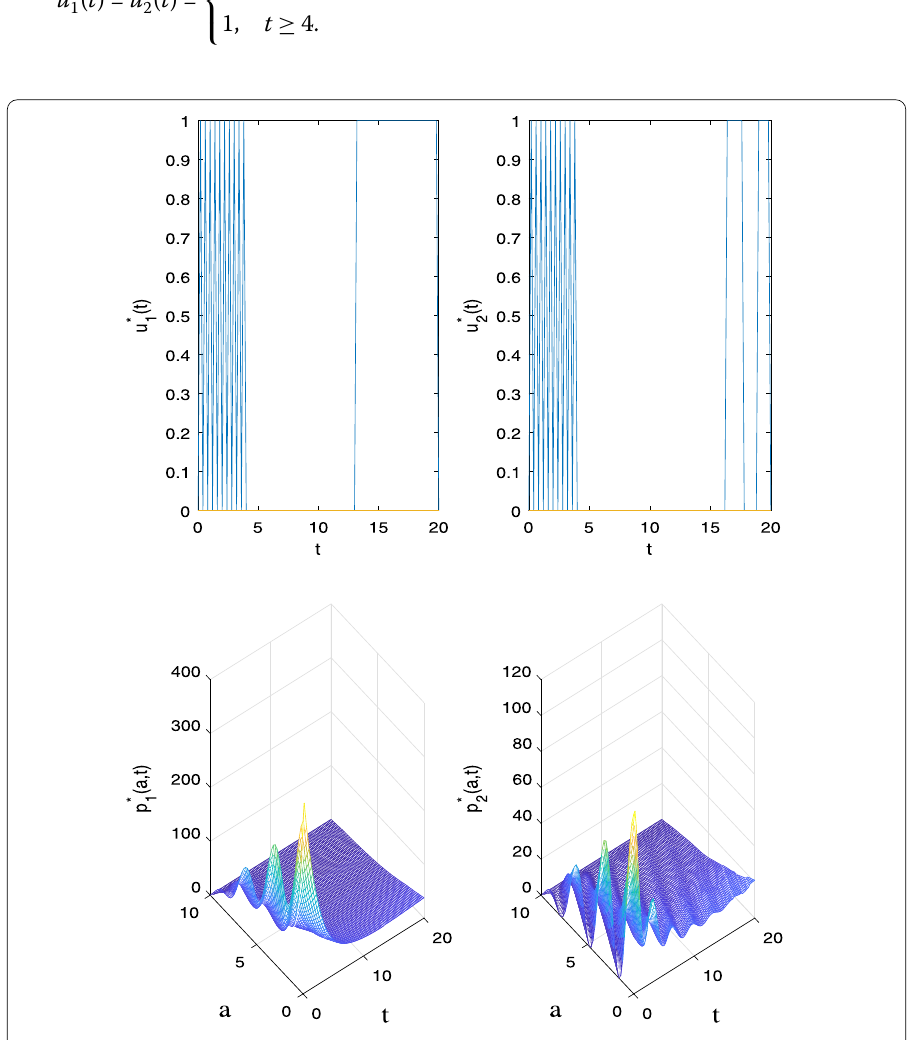
Figure 1 Optimal controls u ∗ 1 , u ∗ 2 and optimal densities p ∗ 1 , p ∗ 2 with s =